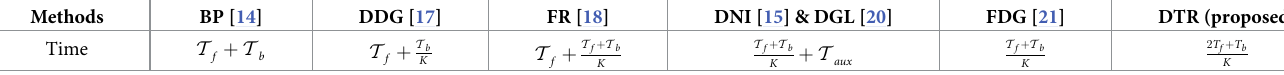
Table 1. Assume in the ideal case that the communication time between different GPUs is negligible and the model is evenly split into K modules. T denote the time taken for forward, backward passes, and the auxiliary network, respectively.